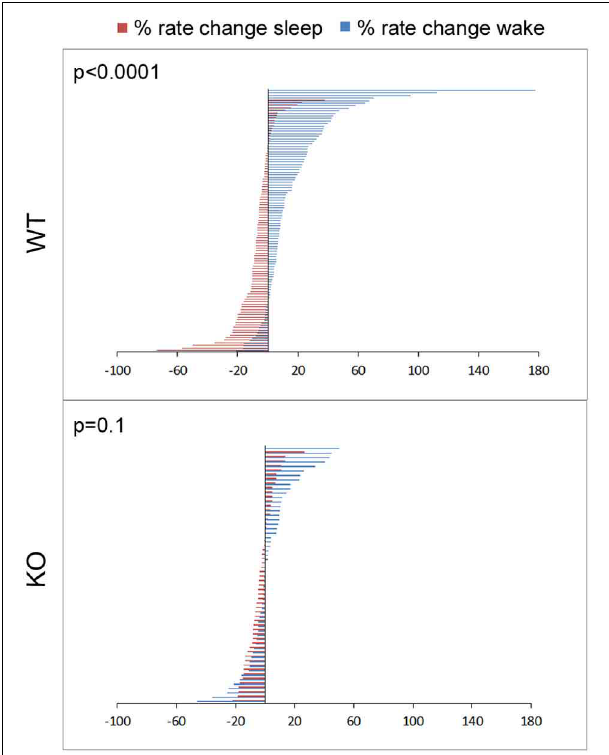
FIGURE 6 | Physiology of sleep and wake state related glutamate dynamics in WT vs. KO mice. Percent rate of change of glutamate concentrations in extracellular space following transitions from sleep-wake to wake-sleep states on EEG, happen within minutes. Percent rate of change of glutamate over the first 5min of transitioning to a sleep or wake state for all sleep-wake cycles in the study ( n = 103 and 58 WT and KO respectively) were defined by 2 significantly different and opposite glutamate dynamics with very little overlap between the 2 transitions phases in WT mice. This difference was obliterated in KO mice due to dysfunction of the activity dependent glutamate homeostasis that distinguished the dynamics between the 2 transition phases and genotypes at 7 weeks